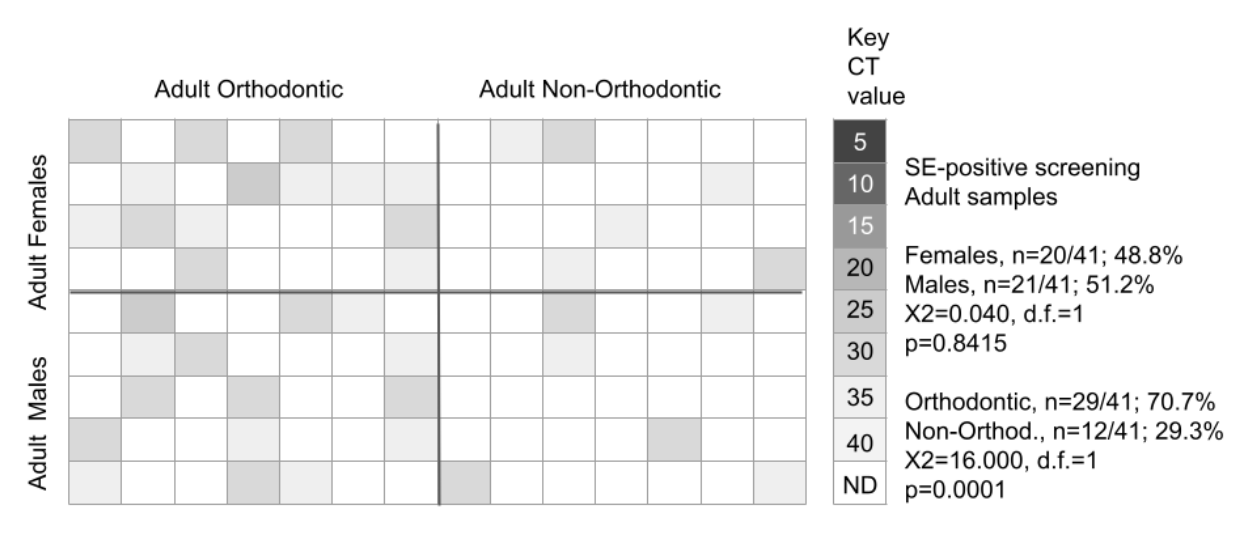
Figure 2. qPCR screening of adult samples for Slackia exigua (SE). Screening revealed n =